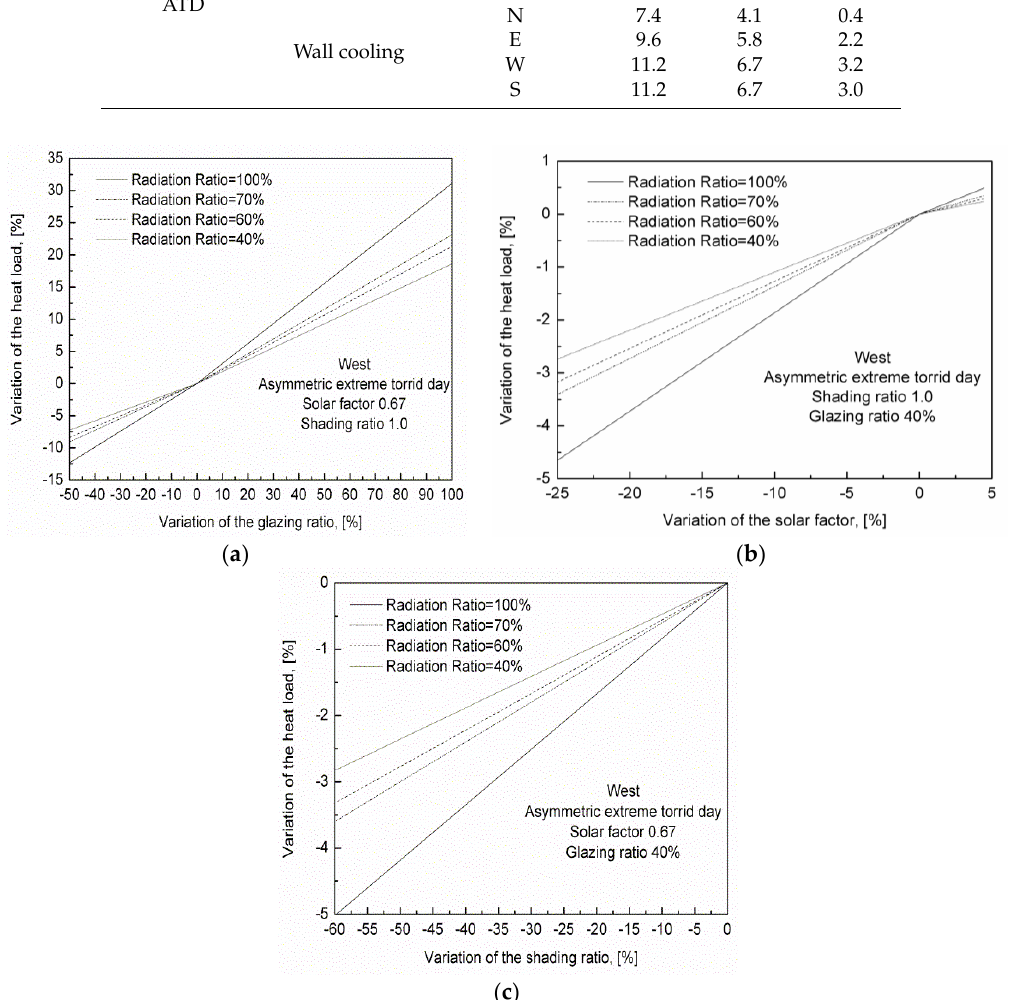
Figure 6. Heat load sensitivity in function of the radiation ratio. ( a ) g = 0.67, F obst = 1.0; ( b ) F obst = 1.0, Gr = 40%; ( c ) g = 0.67; Gr = 40%.